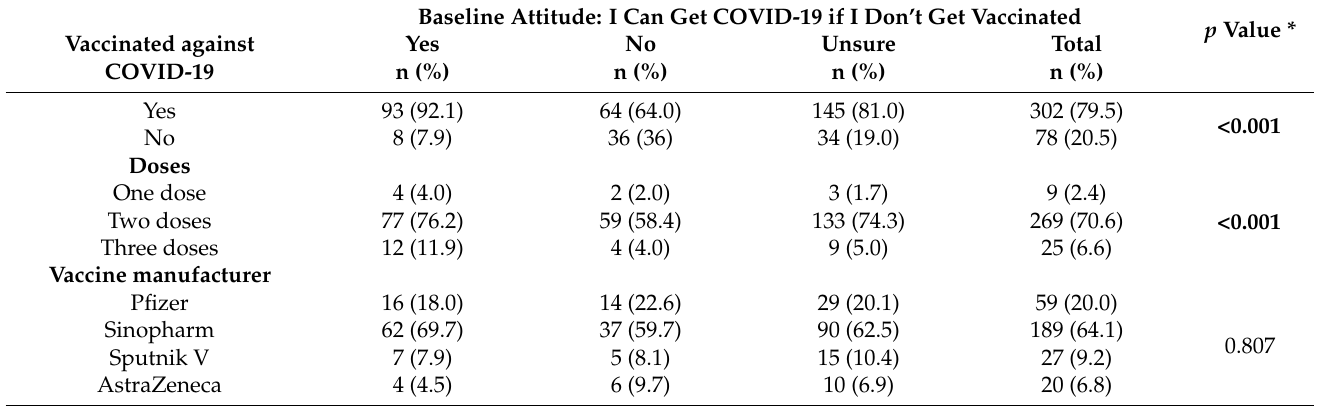
Table 4. Vaccination characteristics of participants based on attitude toward the possibility of getting